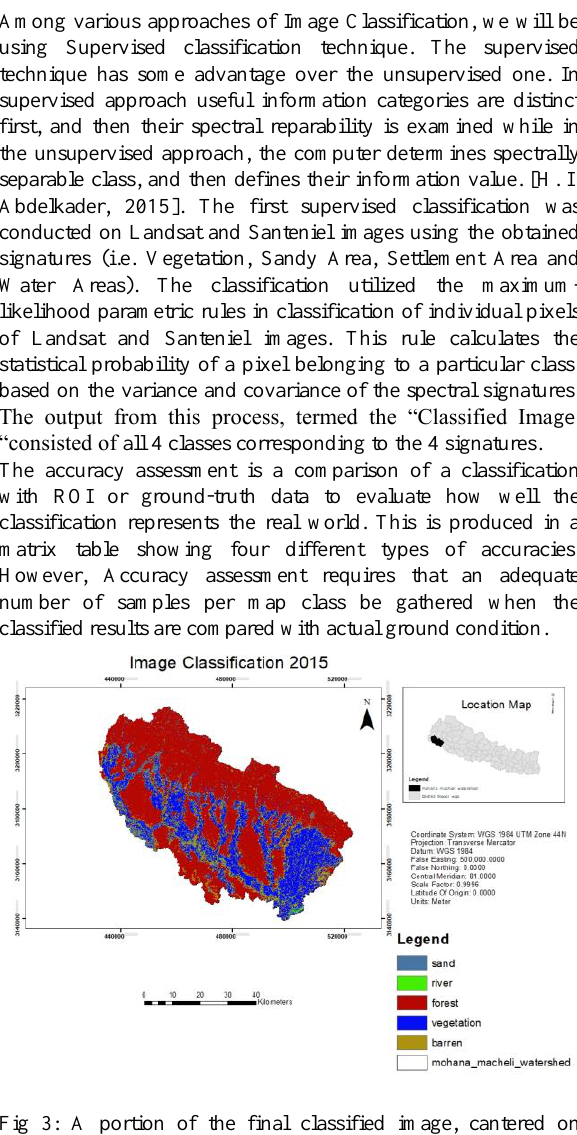
Fig 3: A portion of the final classified image, cantered on Mohana-Macheli watershed of